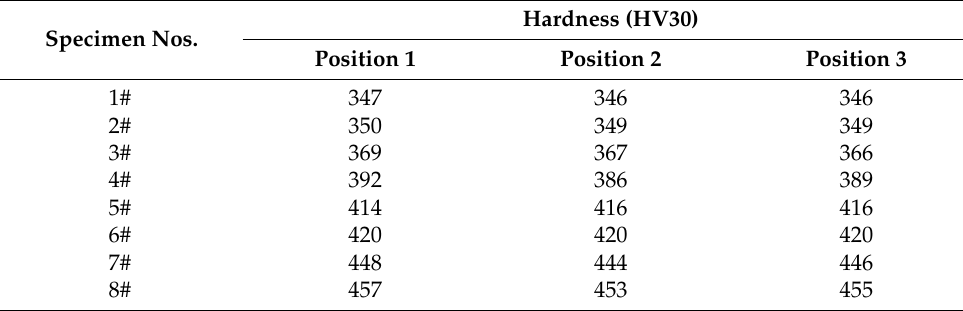
Table 1. The measured surface hardness of the prepared samples. Specimen